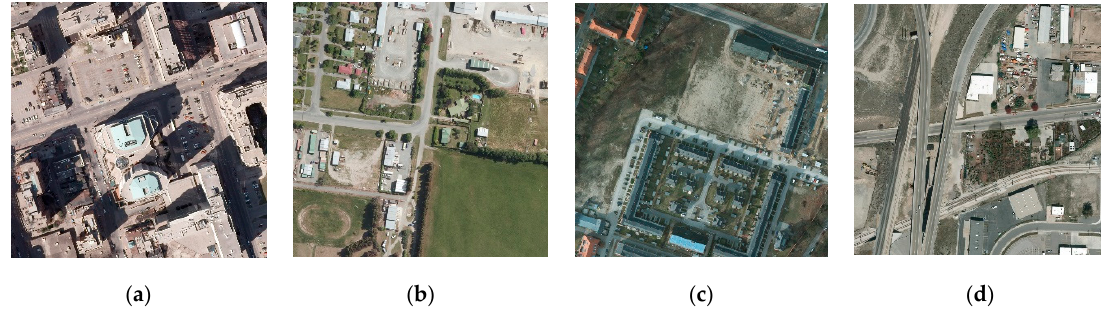
Figure 4. Image examples from the four study regions from the Cars Overhead with Context (COWC) dataset: ( a ) Toronto, Canada; ( b ) Selwyn, New Zealand; ( c ) Potsdam, Germany; and ( d ) Utah, United States.